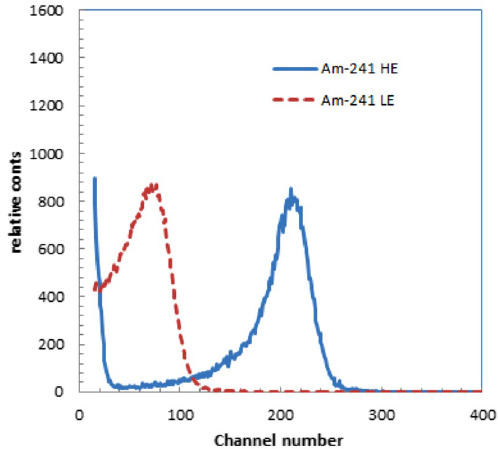
Figure 3. Energy spectra of two types of alpha sources used for experiments.